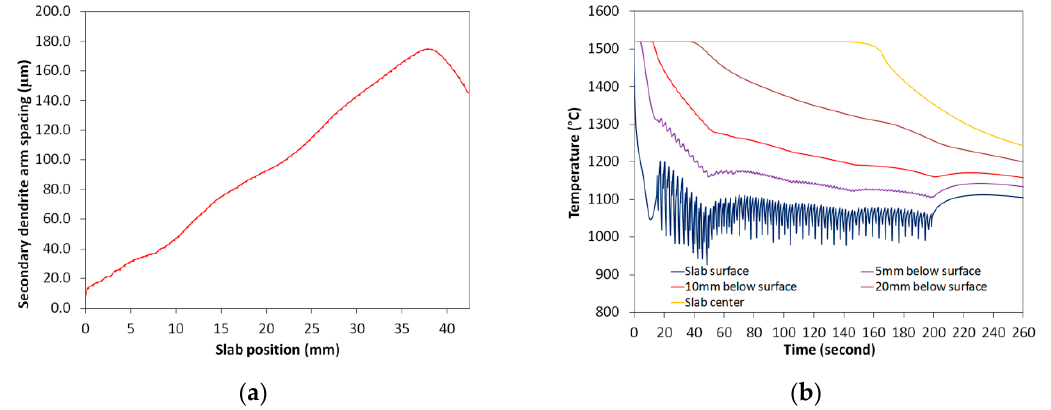
Figure 4. CON1D V7.0 slab casting heat transfer model predicted: ( a ) secondary dendrite arm spacing as a function of position within the API X70 slab; and ( b ) temperature paths at the surface, 5, 10, and 20 mm below the surface, and the center of the slab.